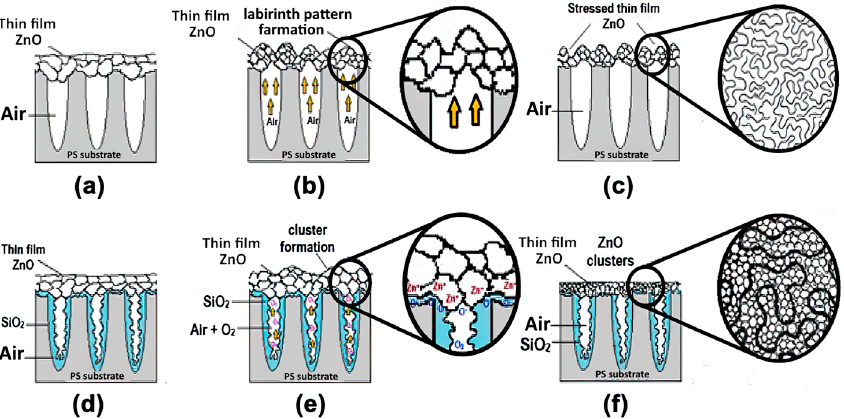
Figure 5. Mechanisms of zinc oxide film growth on the surface of porous silicon [38]: ( a – c ) Stages of the formation of granular labyrinth pattern on SiO 2 /Si substrate; ( d – f ) stages of the deposition of ZnO on SiO 2 /Si substrate with small pores.